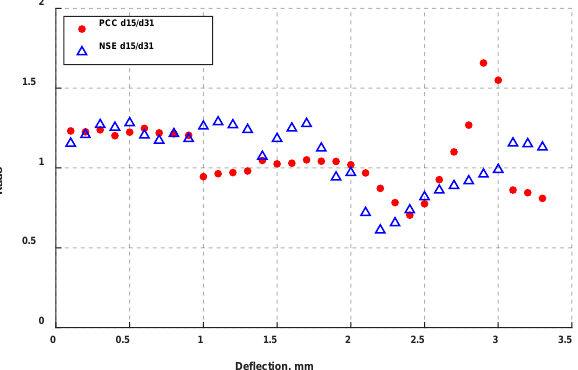
Figure 12. Damage index ratios of d15 PZT to d31 PZT for PCC and NSE.